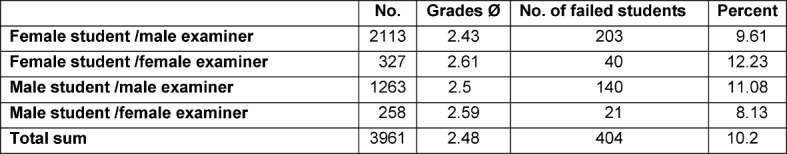
Average grades , number and percentage of failed students compared to gender of students and examiners.